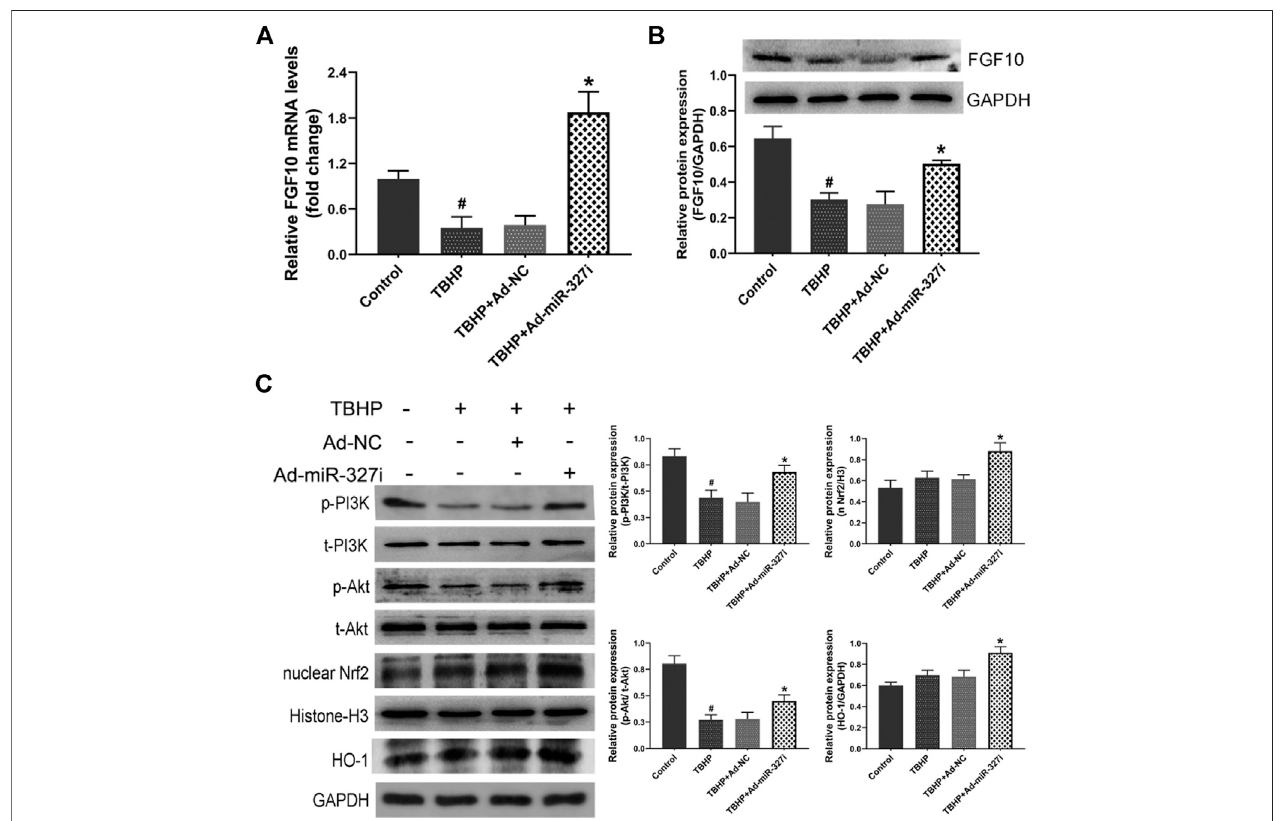
FIGURE 7 | Effects of downregulation of miR-327 on the FGF10/Akt/Nrf2 signaling pathway in TBHP-treated H9c2 cells. FGF10 mRNA and protein levels were detected by qRT-PCR and Western blot analysis after TBHP treatment (A, B) . Downstream protein p-PI3K and t-PI3K, t-Akt and p -Akt, antioxidant-related protein nucleusNrf2,andHO-1weremeasuredbytheWesternblotanalysisinH9c2cells (C) .Dataareexpressedasthemean ± SD( n (cid:2) 3);# p < 0.05versustheControlgroup; * p < 0.05 versus the Ad-NC